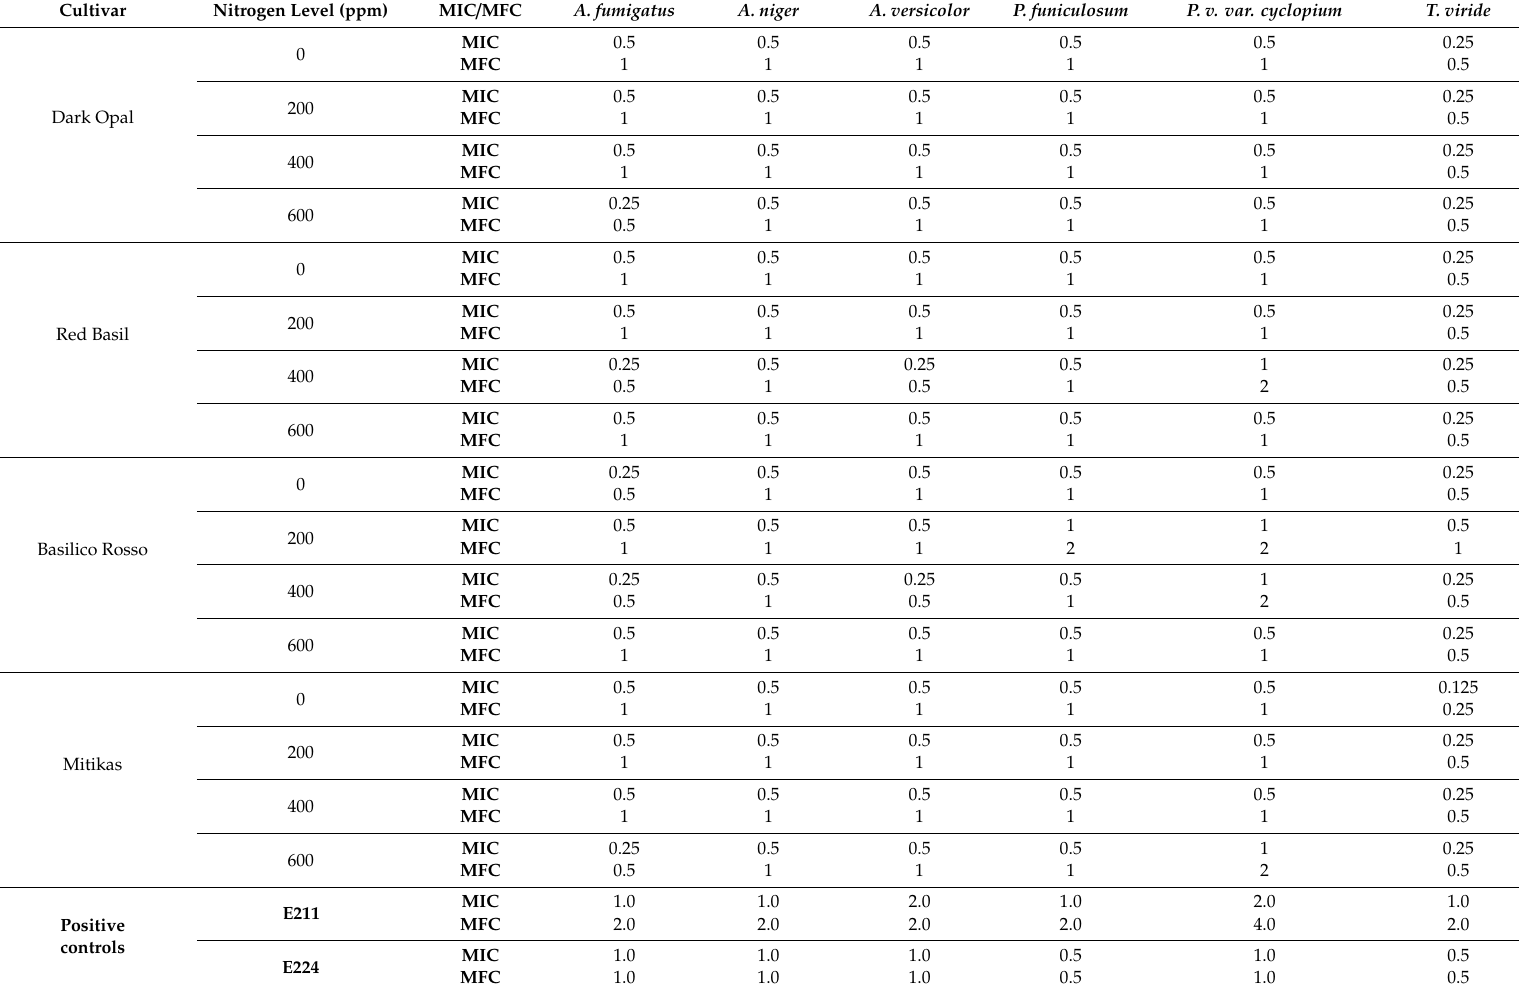
Table 8. Antifungal activity (MIC and minimal fungicidal concentration (MFC) mg / mL) of the leaves’ hydroethanolic extracts (mg / mL) of the studied basil genotypes in relation to nitrogen